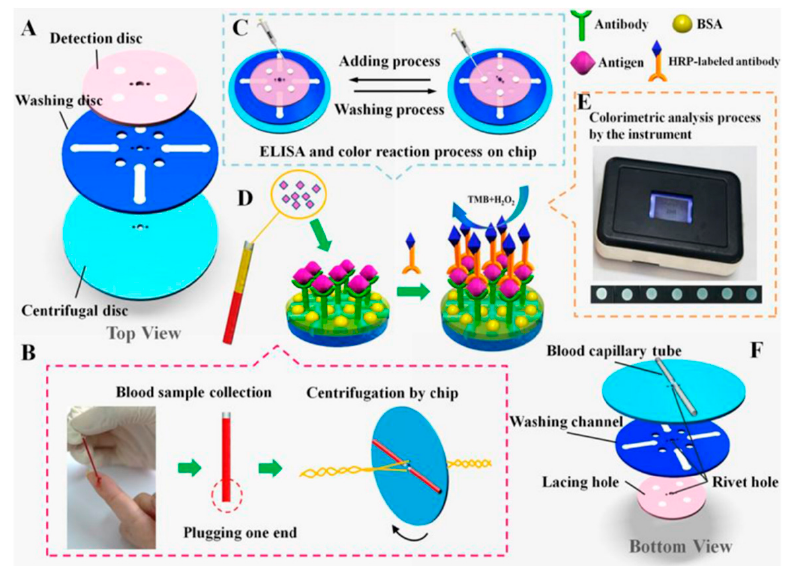
Figure 5. Structure and operation of FICA- μ PADs. ( A ) Decomposition of a FICA- μ PAD. ( B ) Blood samples from a finger puncture were placed into a capillary tube and centrifuged. ( C – E ) ELISA generates signals using a portable inter-reader. ( F ) Base image of the FICA- μ Pad, highlighting immune response areas, washing channels, and vascularization vessels. Reprinted with permission from [82]. Copyright 2020 Elsevier.